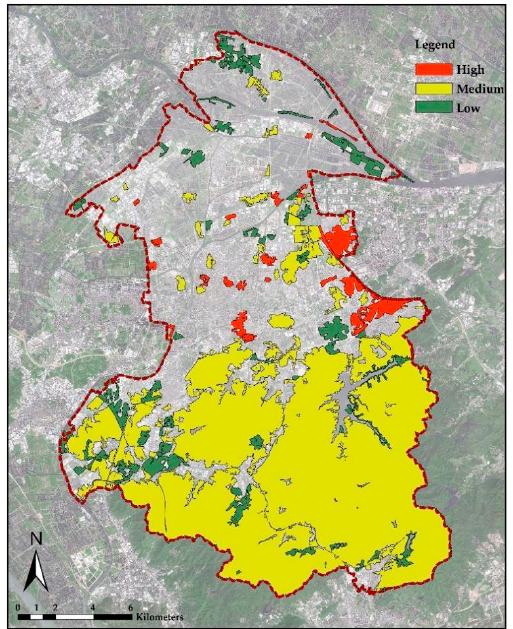
Figure 15. Grading of UGI landscape activity in the study area.